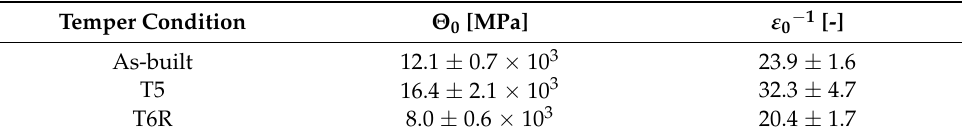
Table 4. Parameters of Voce equation, Θ 0 and ε 0 − 1 , obtained by the analysis of strain hardening behavior of the AlSi7Mg PBF-LB alloy tested in the as-built, T5 and T6R condition. Temper Condition